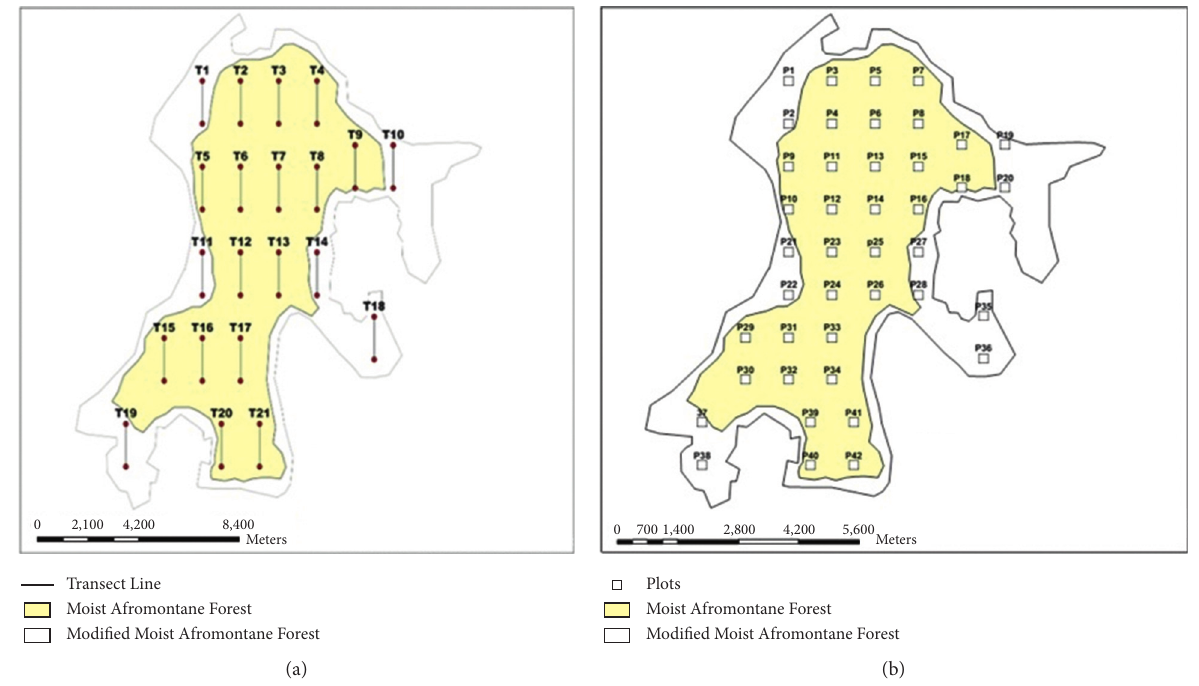
Figure 4: (a) Line transects layout and (b) plots layout at Nensebo forest, southern